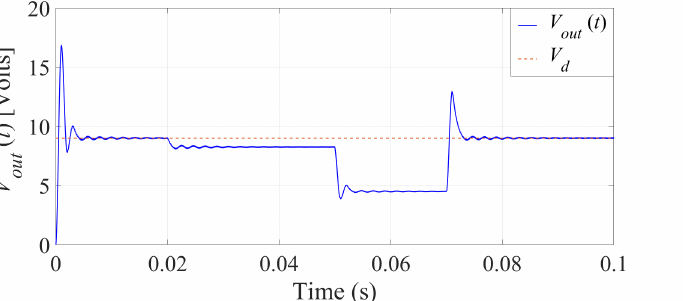
Figure 3. Output voltage ( V out ( t ) ) of the buck converter system with input time-varying voltage ( V in ( t )